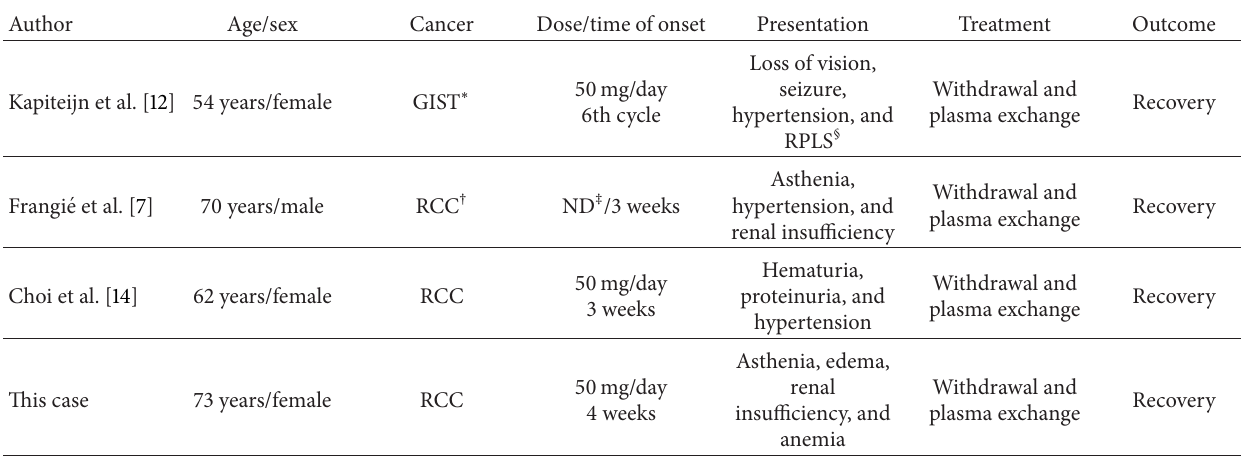
Table 1: Summary of cases of TTP associated with sunitinib in the